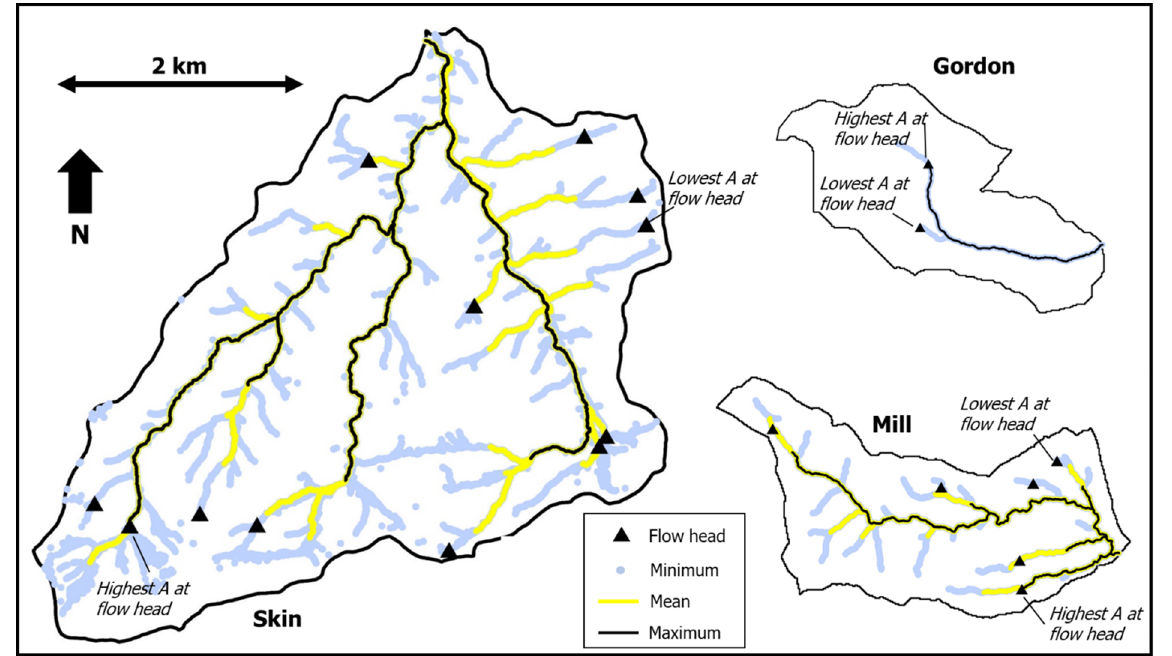
Figure 6. Flow heads mapped in the field (black triangles) compared to the stream networks derived using the thresholds of drainage area (A). The thresholds applied were the minimum, maximum, and mean values of A identified at the catchment’s flow heads. Any grid cell with A exceeding the threshold was mapped as a channel. Gordon shows only the minimum and maximum channel extents because the catchment had only two flow heads.